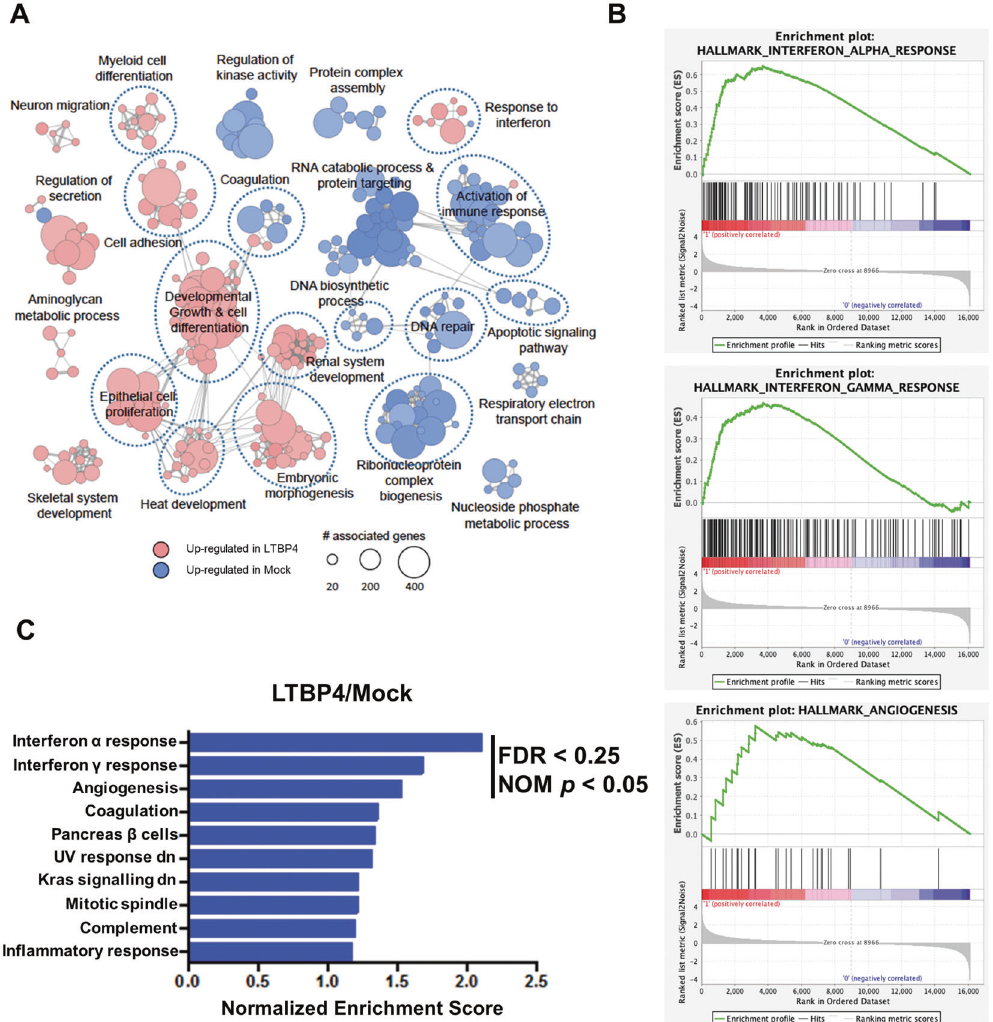
Fig. 3 LTBP4 overexpression enriches differentiation, immune response, and angiogenesis phenotypes in HK-2 cells. A Enrichment map showing signi fi cantly perturbed functions in the LTBP4 overexpression group compared to those in Mock cells based on Gene Ontology gene sets. Edges indicate shared genes. B Gene set enrichment analysis (GSEA) plot for representative gene sets enriched in LTBP4 overexpression vs. Mock cells. C Top 10 biological functions enriched in LTBP4 overexpression vs. Mock cells. FDR: false discovery rate. NOM p : nominal p